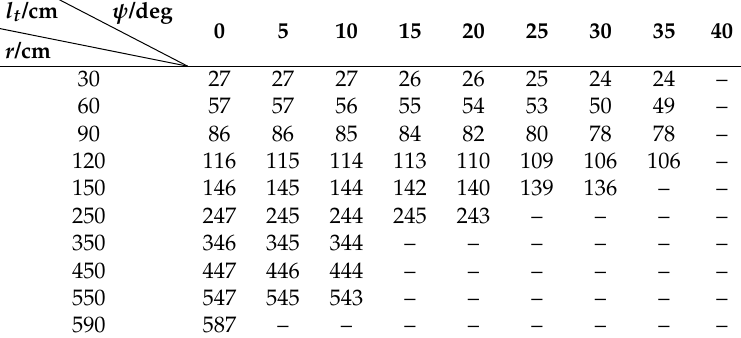
Table 2. Measurements of MB1222 at various angles and distances.